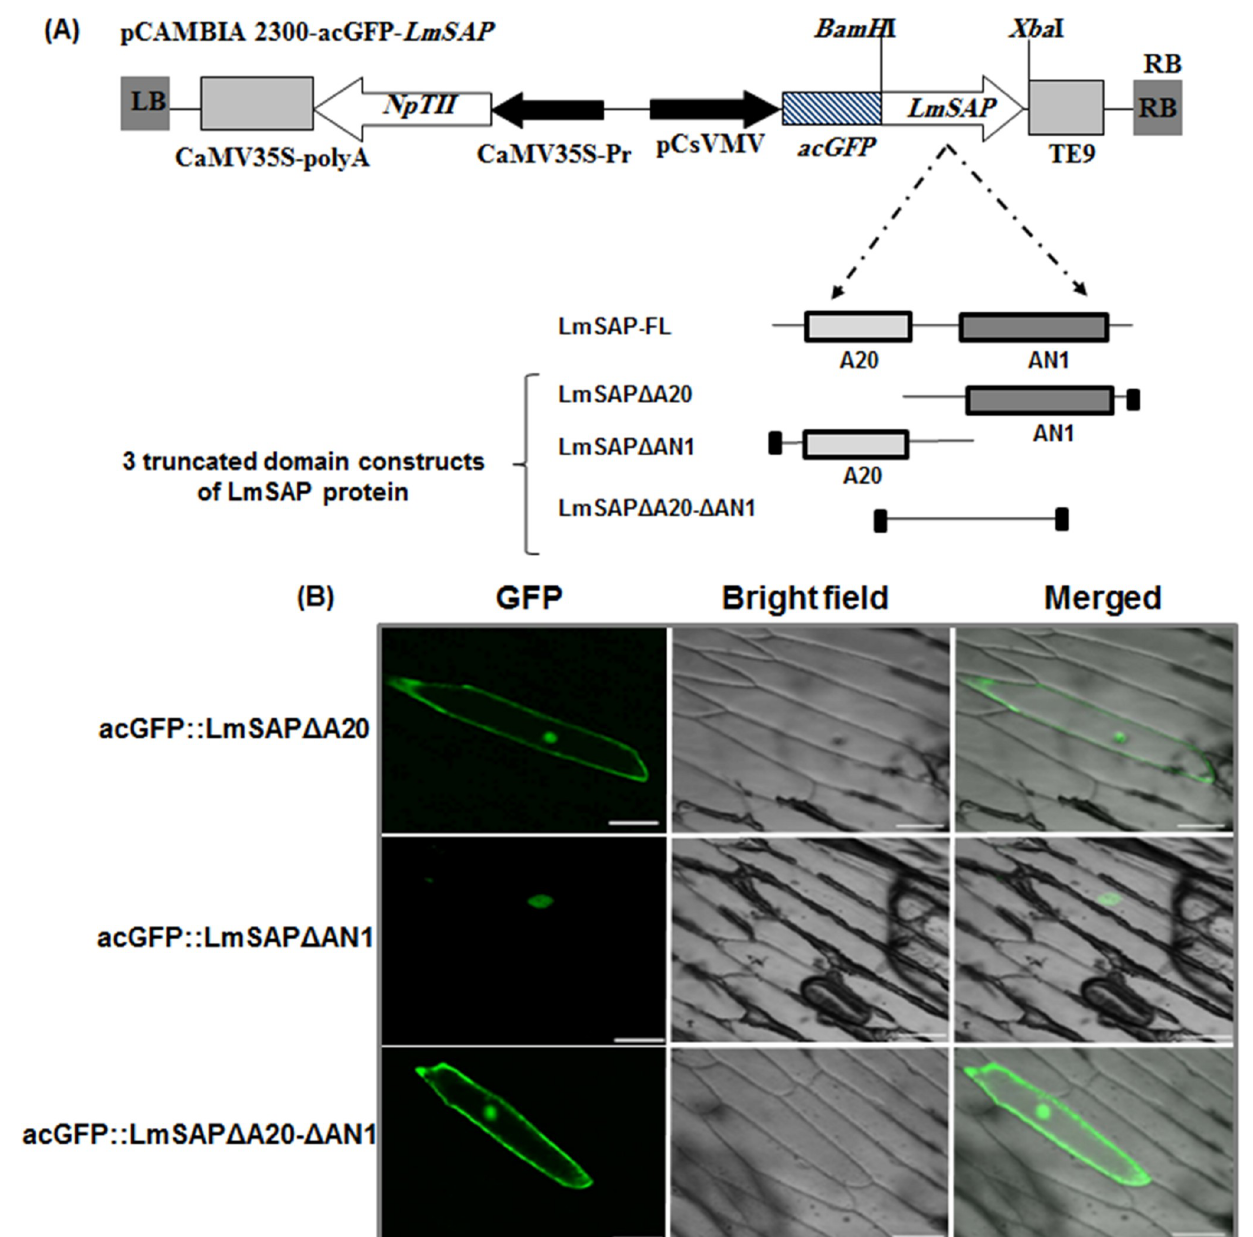
Fig 3. Subcellular localization of the truncated forms of LmSAP protein. ( A ) Schematic diagram of the pCAMBIA2300-acGFP-LmSAP constructs showing the three truncated domains, LmSAP Δ A20, LmSAP Δ AN1, and LmSAP Δ A20- Δ AN1. ( B ) Localization of LmSAP Δ A20, LmSAP Δ AN1, and LmSAP Δ A20- Δ AN1 constructs with the acGFP fusion protein in onion epidermal cells following particle bombardment, as visualized using confocal microscopy. GFP (left), bright field (middle), and merged (right) images are shown. Bars = 100 μ m.